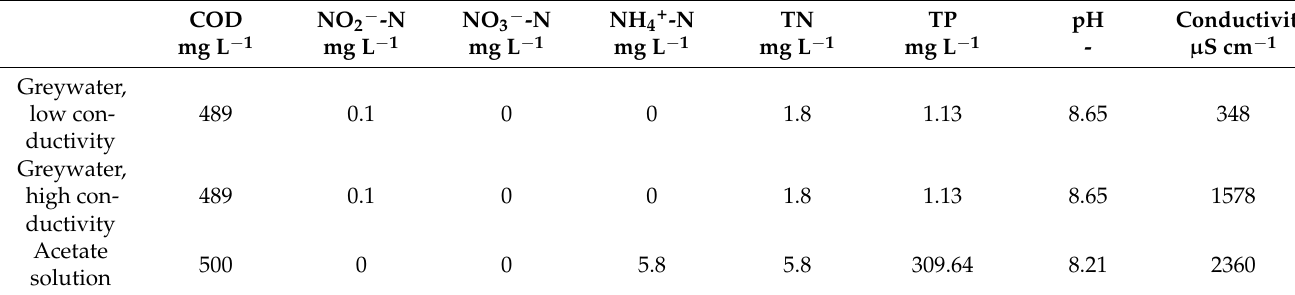
Table 1. Characteristics of the synthetic microbial fuel cell (MFC) greywater (GW) influents. COD: chemical oxygen de- mand; TN: total nitrogen; TP: total phosphorus.